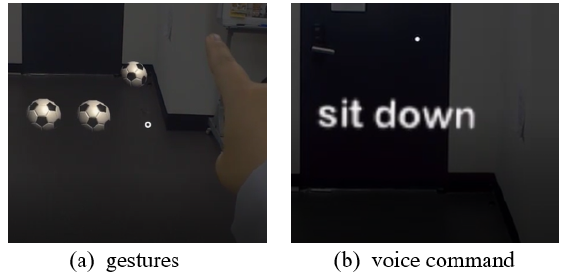
Figure 7. Examples of tutorial.